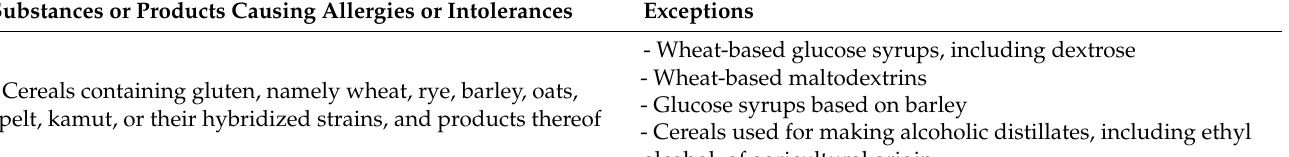
Table 1. Mandatory declaration substances or products causing allergies or intolerances in the European Union according to EU Regulation 1169/2011